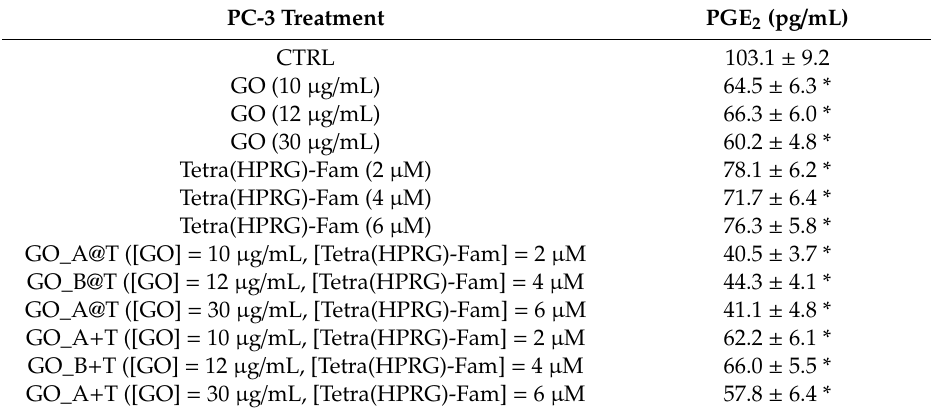
Table 1. Prostaglandin (PGE 2 ) production in PC-3 medium, after di ff erent treatments. Values (means ± SEM) are from three independent experiments ( n = 3). ANOVA was used to compare PGE2 production in all experimental conditions. * p < 0.01 vs. control cells.